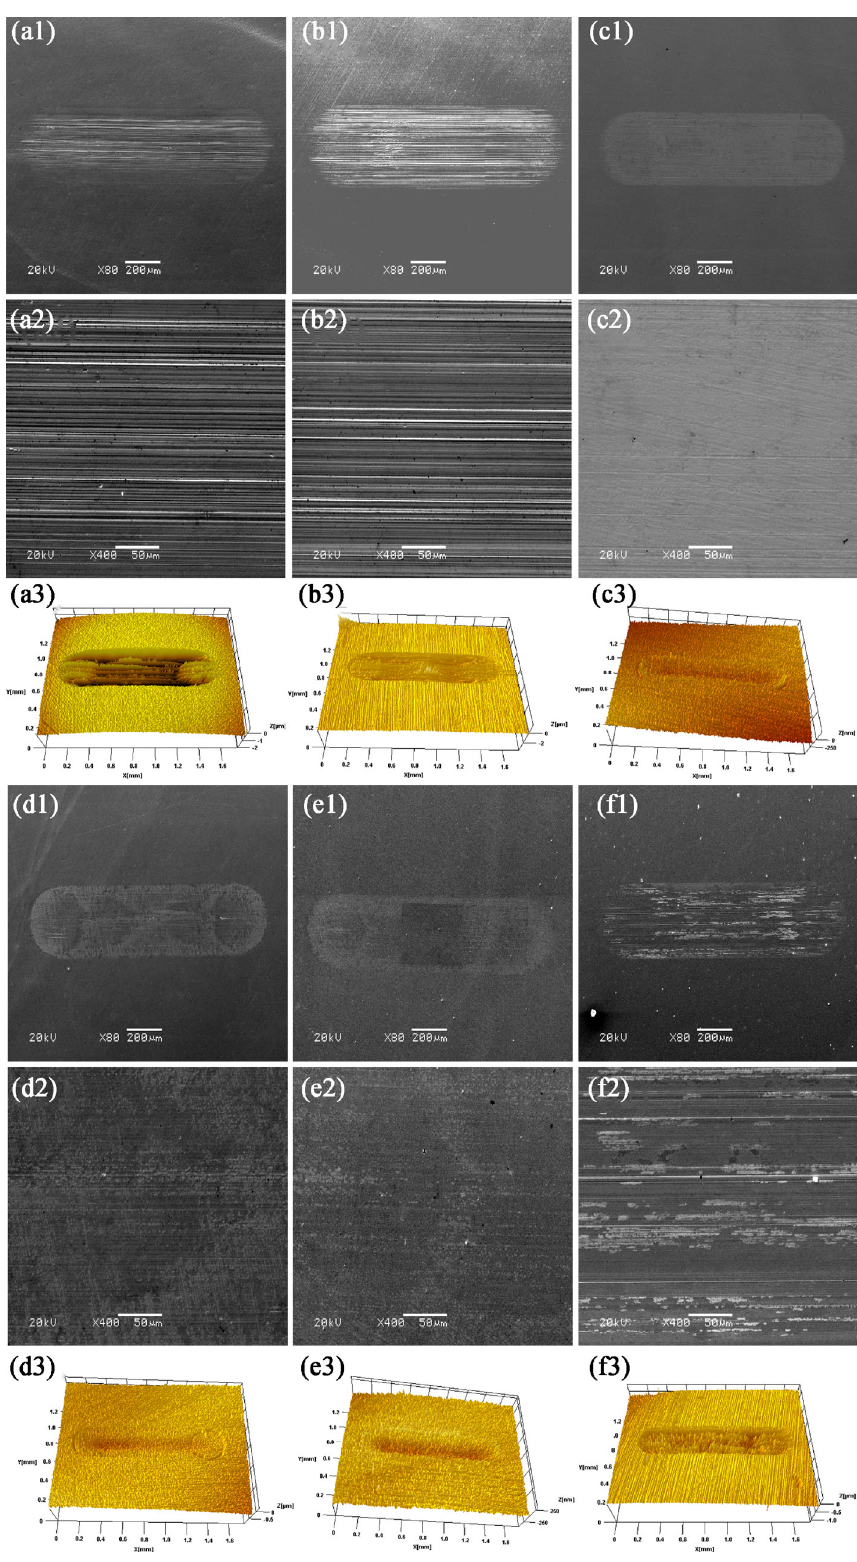
Fig. 7 SEM micrographs and 3D optical microscopic images of the worn steel discs with different lubricants: [Ch][Gly] (a1, a2, and a3); [Ch][Ala] (b1, b2, and b3); [Ch][Ile] (c1, c2, and c3); [Ch][Ser] (d1, d2, and d3); [Ch][Phe] (e1, e2, and e3); and [C 6 mim][NTf 2 ] (f1, f2, and